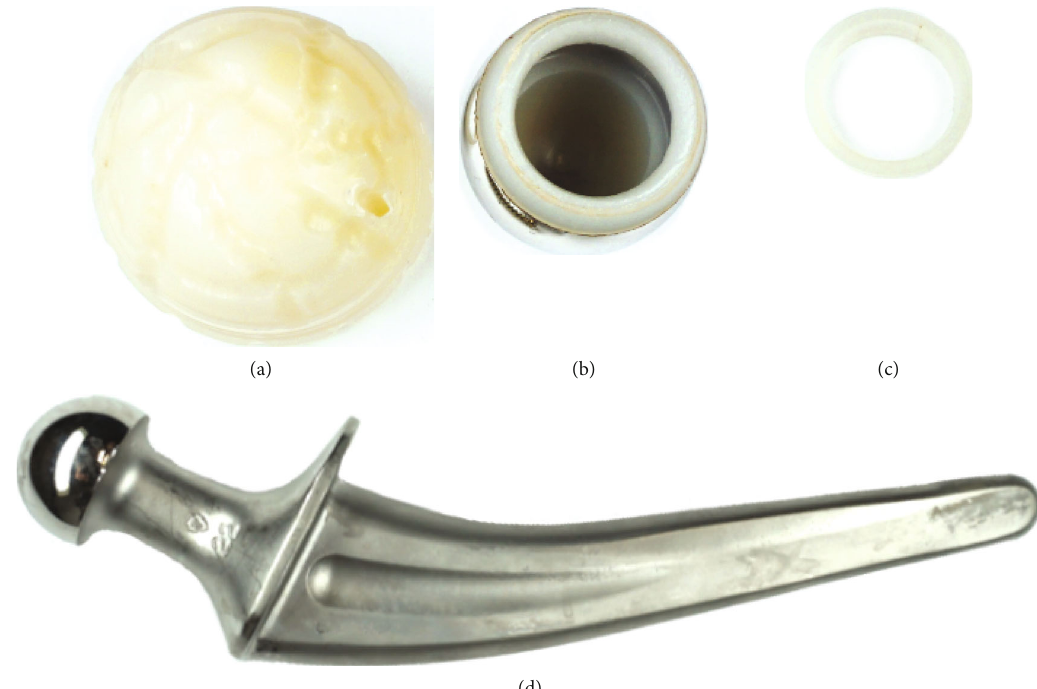
Figure 5: Explanted cup liner (a), bipolar head (b) with a constraining ring (c), and the monoblock stem (d).